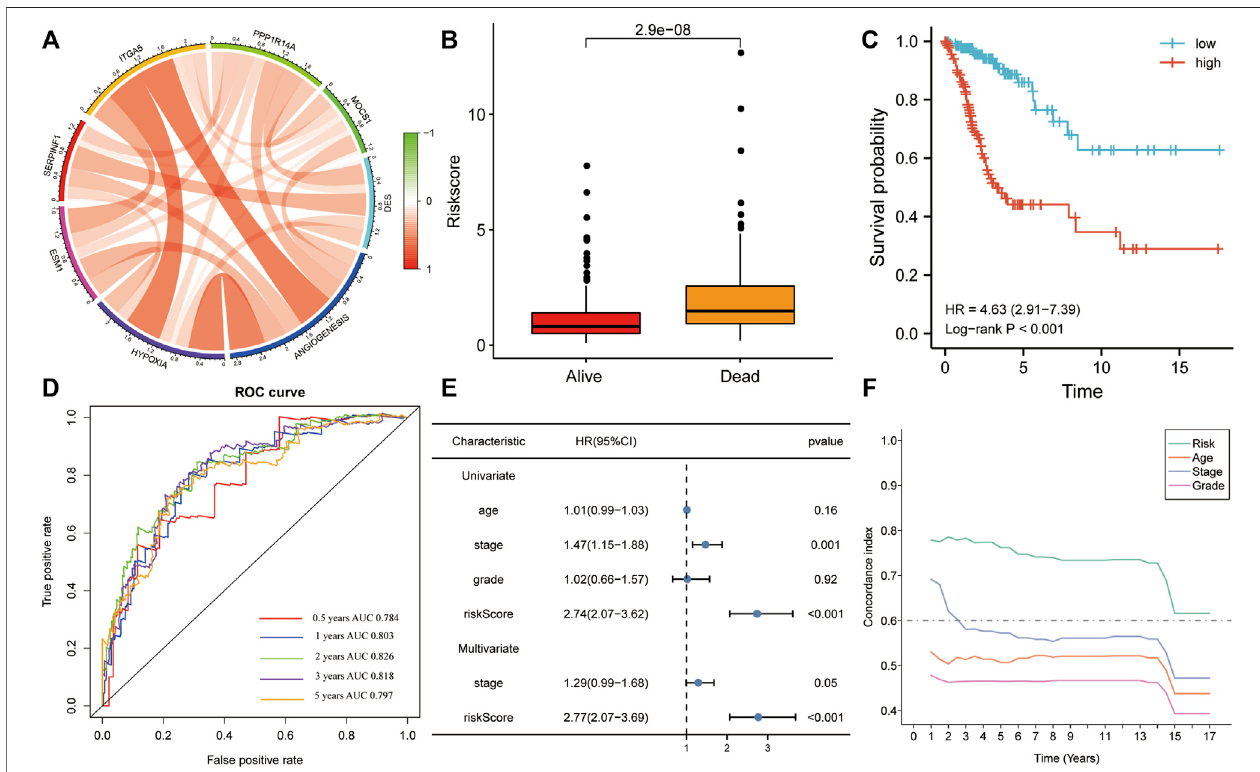
FIGURE 4 | The risk score was the only signi fi cant independent risk factor affecting OS in the training set. (A) Correlation of the gene signature with hypoxia and angiogenesis . (B) The risk score was signi fi cantly higher in the mortality group during follow-up. (C) Patients with a high risk score had a poorer OS, according to KM analysis. (D) TheriskscorewasagoodpredictorofOS(AUC > 0.7). (E) UnivariateandmultivariateCoxregressionforOSrevealedthatriskscorewastheonlysigni fi cant independent risk factor among multiple clinicopathological variables. (F) The C-index indicated that the risk score had the best OS predictive ability among